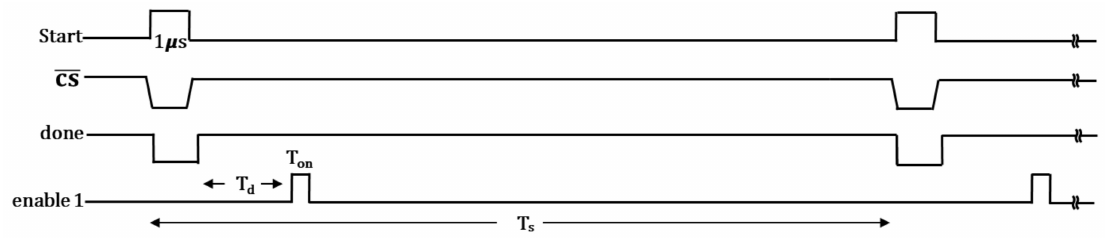
Figure 7. Timing diagram of the control